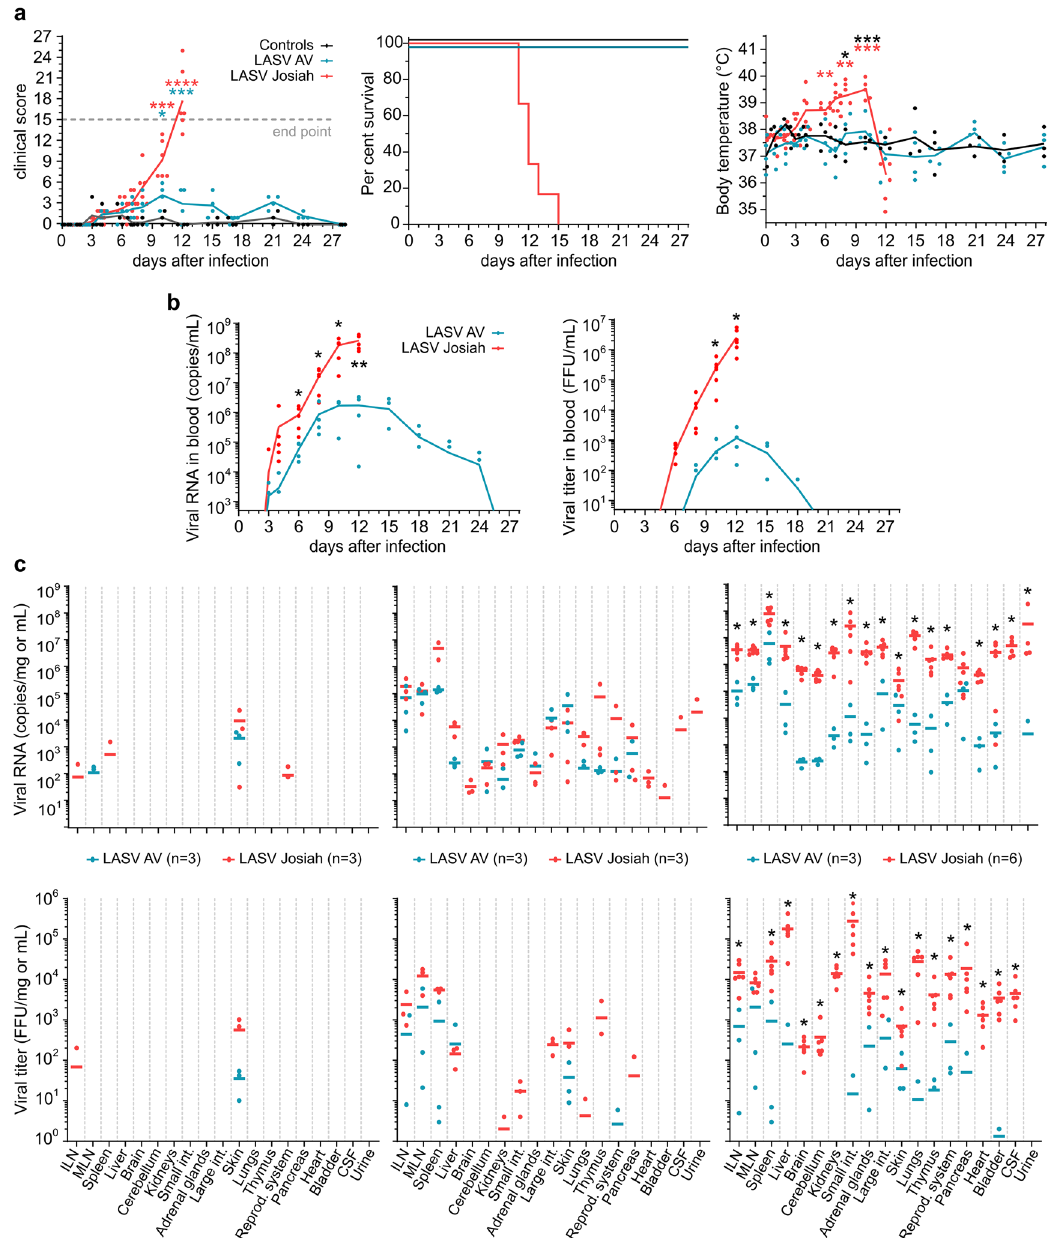
Fig. 1 Clinical and virological features of Lassa fever. a Clinical score, survival rate, and monitoring of body temperature are presented. Results show mean values and individual data for each cohort, except for survival rate, represented with a Kaplan – Meier curve. Controls ( n = 3), LASV-AV ( n = 4), LASV-Josiah ( n = 6). * p < 0.05, ** p < 0.01, *** p < 0.001, **** p < 0.0001, as determined by a one-way ANOVA multiple comparisons test for analysis between controls and AV- and Josiah-infected animals and by a t test for comparison between only controls and AV-infected NHPs. Red asterisks indicate a signi fi cant difference between LASV-Josiah and controls, blue asterisks a signi fi cant difference between LASV-AV and controls, and black asterisks a signi fi cant difference between LASV-Josiah and LASV-AV. b Quanti fi cation of viral load and infectious particles in the plasma of animals according to the time after LASV infection. Mean values of each cohort and individual data points are presented as the number of viral RNA copies/ml (viral load) or FFU/ ml (infectious particles) according to the time after challenge with AV (blue dots) or Josiah (red dots). LASV-AV ( n = 4), LASV-Josiah ( n = 6). The individual data at the time before the death of all LASV-Josiah-infected primates were used to calculate the mean determined at 12 DPI * p < 0.05, ** p < 0.01, as determined by a Student ’ s t test. c Quanti fi cation of viral RNA copies and infectious particles per milligram of various tissues, including inguinal lymph nodes (ILN), mesenteric lymph nodes (MLN), small intestine (Small int.), large intestine (Large int.), the reproductive system (ovaries or testicles) (Reprod. system), and cerebrospinal fl uid (CSF) at 2 (left panel), 5 (middle panel), and 11 (right panel) DPI. Individual and mean values are presented for the two cohorts. * p < 0.05, as determined by a Student ’ s t adrenals and central nervous system (CNS). In these animals, the animals, the presence of infectious particles in the lymphoid organs, viral RNA to titer ratio, an indicator of the ef fi ciency of viral liver, adrenal glands, intestines, skin, lungs, reproductive system, replication, ranged between 100 and 1000 for most tissues, except and pancreas was heterogeneous. In contrast, all organs of Josiah- for brain and cerebellum, for which it was ~3000, and liver and infected NHPs contained very high LASV titers, particularly the